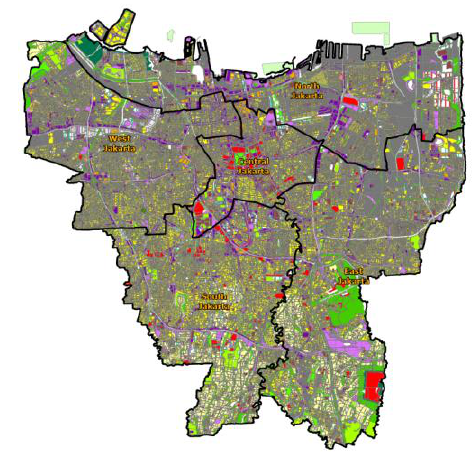
Figure 3 . Zoning map of